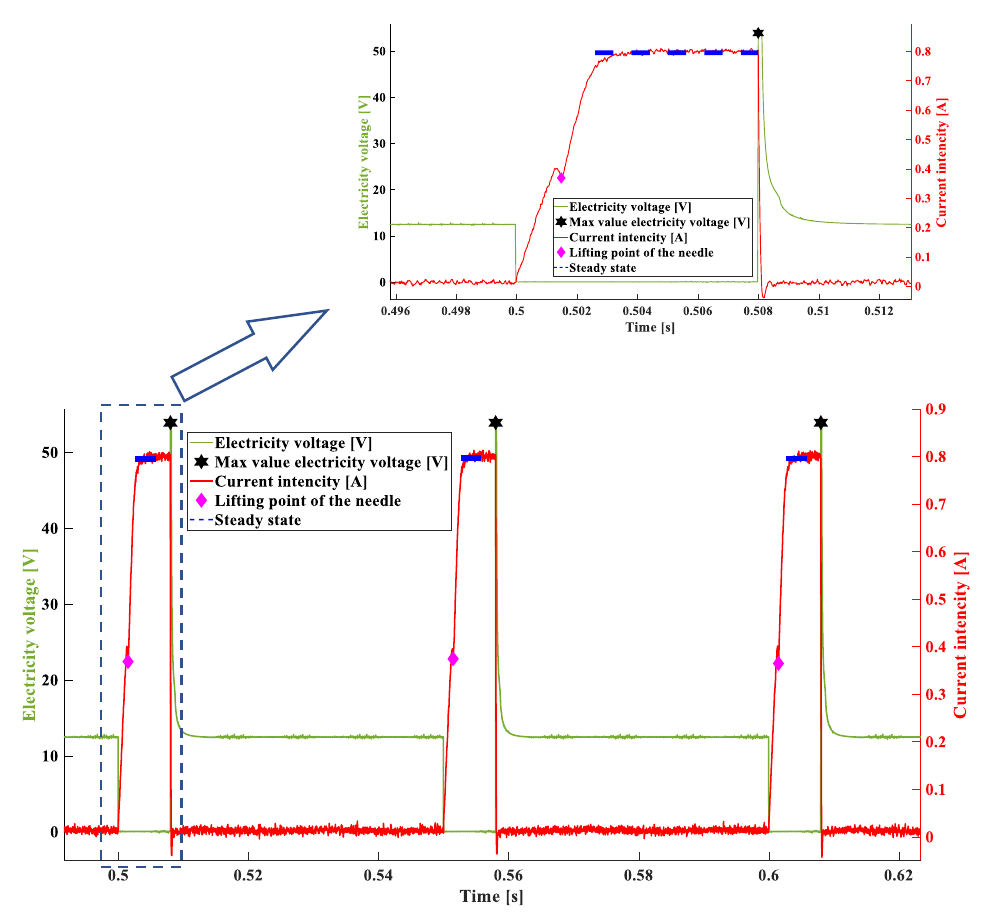
Figure 9. Characteristic values obtained in successive voltage–current waveforms representing the dosage of the fuel injector—exp. I—8 ms, 0.4 MPa. Table 2. User panel filled with selected values—exp. I—8 ms, 0.4 MPa.